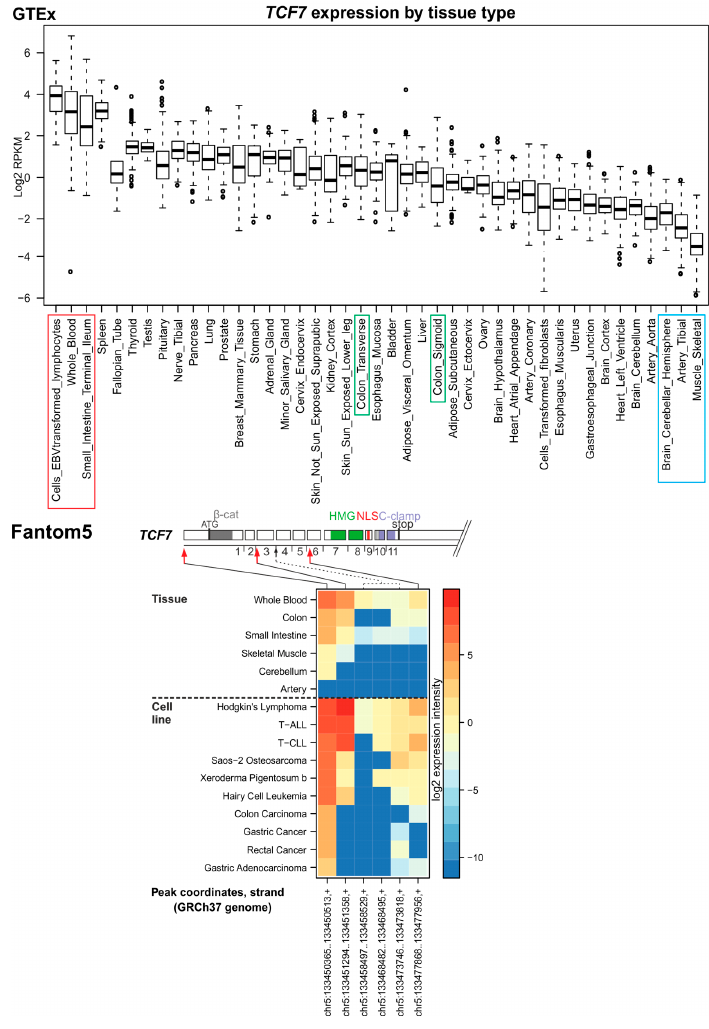
Figure 2. TCF7 expression in human tissues and TSS usage. Upper panel, expression data obtained from the GTEx portal indicating the TCF7 expression levels in 43 different adult human tissues. Three tissue types with the highest and lowest TCF7 expression are boxed in red or blue, respectively. The intestinal specimens are boxed in green, unless they fall into the “high” or “low” expression group. The expression level is given as binary logarithm (log2) of gene-specific reads per gene length (in kilobases) per million of mapped reads (RPKM). The box-and-whiskers plots represent statistical evaluation of results of RNA-seq experiments performed with RNA samples obtained from different individuals. Upper and lower box borders indicate first and third quartiles, respectively. Median is represented by the bold line inside each box. The extent of adjoining values (1.5 interquartile range (IQR)) is depicted by “whiskers”; open circles correspond to outlying samples. Lower panel, mapping TSSs using the Fantom5 project data. Heatmap shows the position of TSSs and their usage as inferred from CAGE. The genome localization of peaks of RNA-seq reads defining individual TSS is indicated below the heatmap; the peaks were also mapped to the gene exon/intron structure (shown above the heatmap). Exon numbers and regions encoding functional domains are depicted (see also Figure 1); for the sake of clarity, the length of introns is not to scale. Red arrows mark peaks (or a group of peaks) representing the major TSSs; a minor TSS is indicated by the black arrow. Putative TSSs located in the last exon and 3 1 untranslated region (3 1 UTR) were omitted. The analysis was performed with tissue samples corresponding to the boxed specimens in the GTEx diagram (shown above the dashed line in the heatmap) except for the EBV-transformed-lymphocyte sample that is not present in the Fantom5 database. In addition, two colonic tissues in the GETx collection, i.e., transverse and sigmoid colon, are represented by only one colon specimen in Fantom5. Results below the dashed line indicate CAGE analysis of RNA samples isolated from 10 cancer/leukemia cell lines with the highest TCF7 expression. T-ALL, T-cell acute lymphoblastic leukemia; T-CLL, T-cell chronic lymphocytic leukemia. The methodology is described in detail in Supplementary